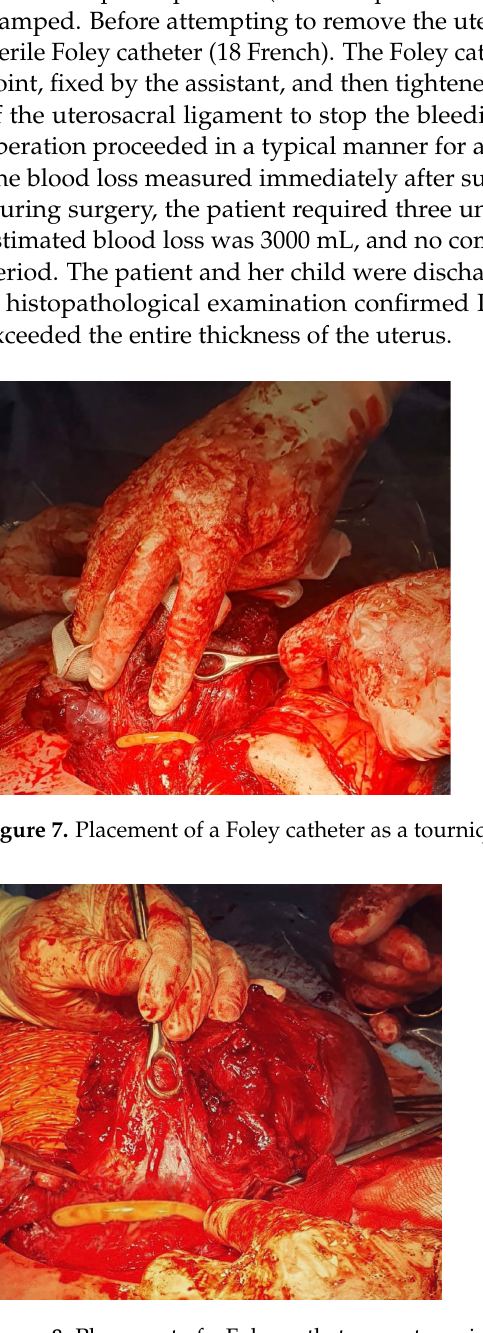
Figure 8. Placement of a Foley catheter as a tourniquet to prevent hemorrhage.